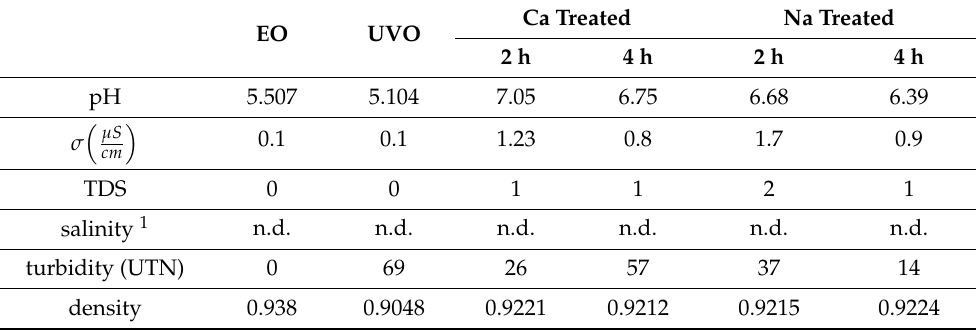
Table 1. Physicochemical parameters for samples of edible oil (EO), UVO, Na, and Ca treated oils. Ca Treated Na Treated EO UVO 2 h 4 h 2 h 4